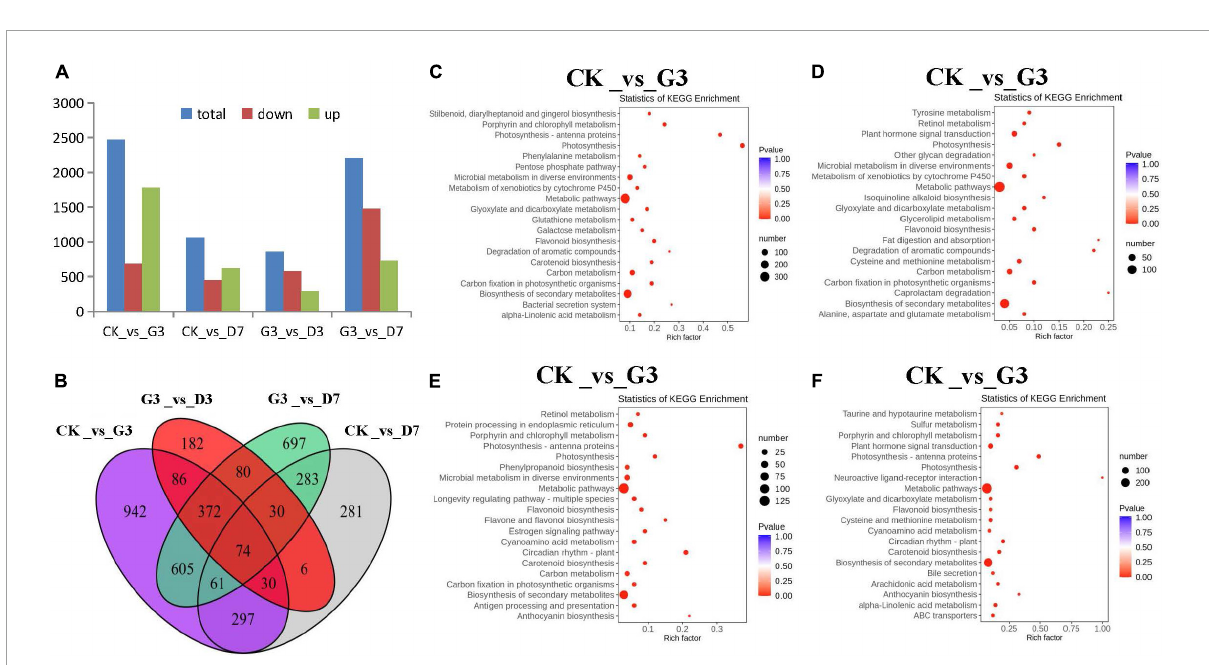
quality of the transcriptome data of each sample was high, which suggests that our transcriptome data were accurate and reliable ( Supplementary Table 6 ). The proportion of reads that were mapped to multiple locations in the genome was 12.49–14.23%, and the proportion of reads with map quality